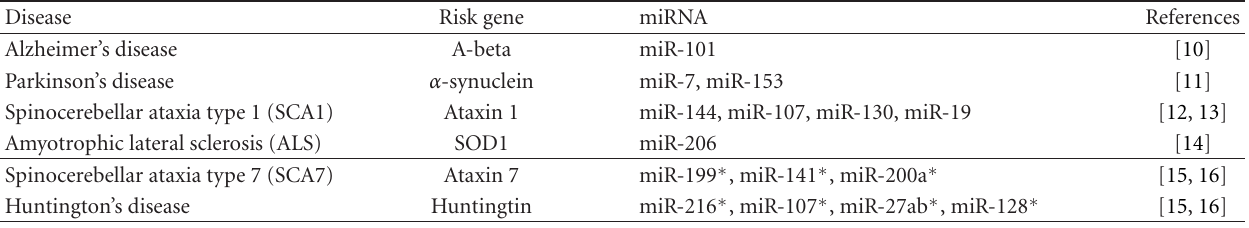
Table 1: List of miRNAs that are reported or have high probability to inhibit the expression of genes linked to neurodegenerative disease